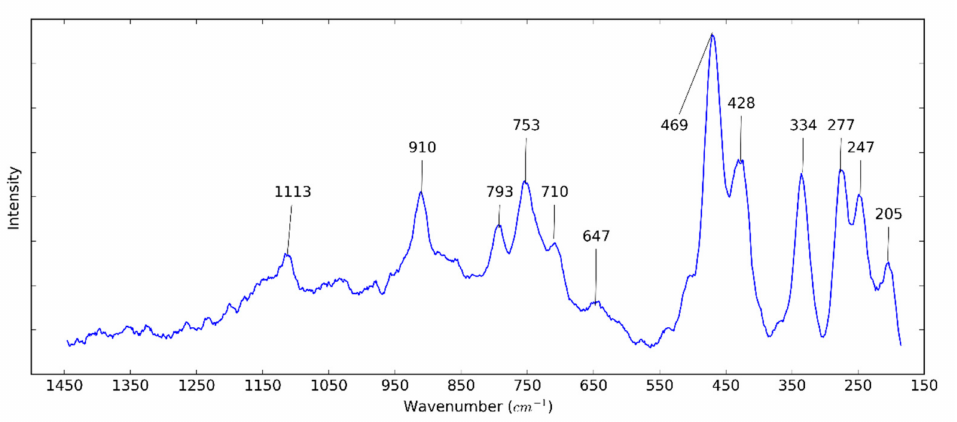
Figure 4. Raman spectrum of HNTs.